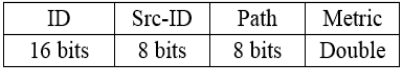
𝐴𝐴 − 𝑅𝑅𝑒𝑒𝑅𝑅𝐴𝐴𝑒𝑒𝑅𝑅𝑒𝑒